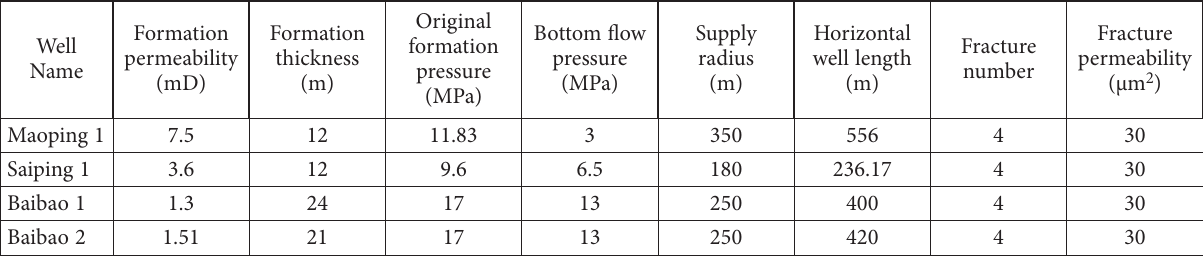
Table 1. The first part of wells